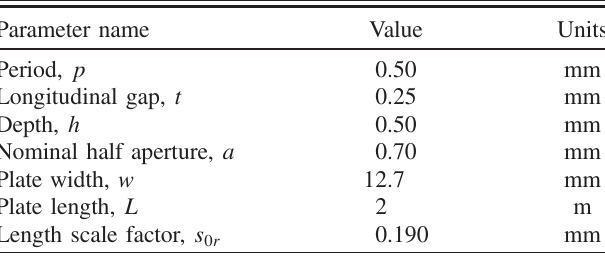
TABLE I. RadiaBeam/LCLS Dechirper parameters. The de- chirper comprises a vertical and a horizontal unit, each of which consists of two flat, corrugated plates. The length scale factor s 0 will be discussed in the